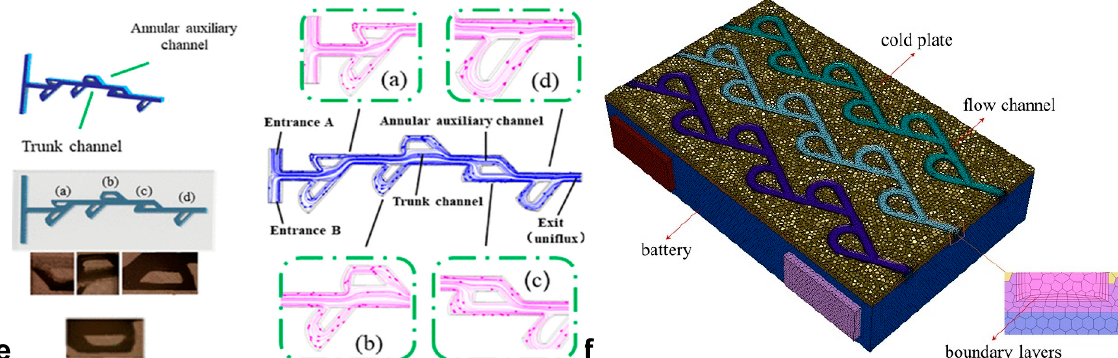
Figure 4. Single-stage TV structure for unidirectional flow components. ( a ) The single-stage TV structure in each inlet of the micromixer. ( b ) The digital integrated micromixer. ( c ) Two-dimensional simulations of pressure and velocity distribution of the fluidic in the TV structure. Reprinted from [24] under Creative Commons license. ( d ) The single-stage TV rectifier in the oscillating heat pipe. Reprinted from [34] with permission, copyright © 2011 Elsevier. ( e ) A multi-stage TV microchannel with an asymmetrical design in micromixer devices. Reprinted from [35] under Creative Commons license. ( f ) A multistage symmetrical TV design using high throughput channels. Reprinted from [36] with permission, copyright © 2022 Elsevier.